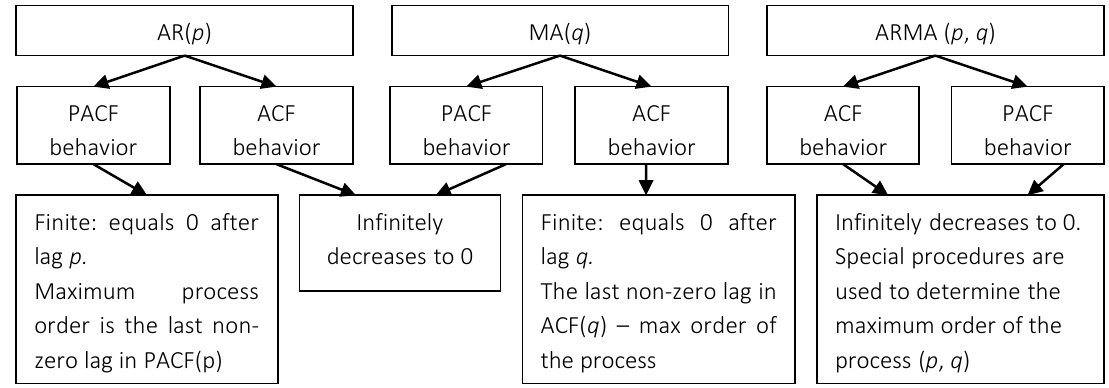
Figure 5. Properties of ACF and PACF functions for MA, AR, and ARMA